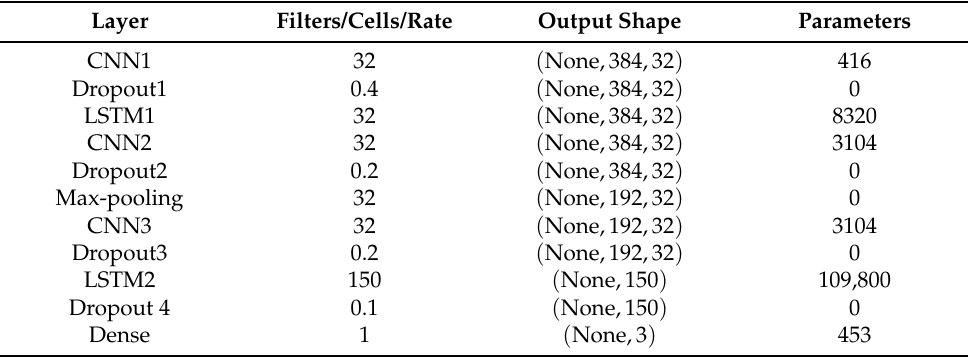
Table 2. Summary of the parameters of the CNN-LSTM architecture.